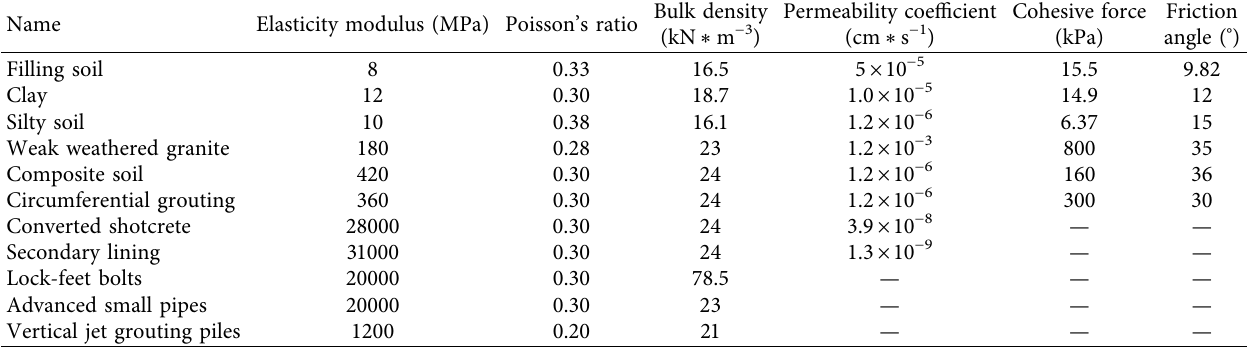
Table 2: Mechanical parameters of main strata and supporting materials [44].